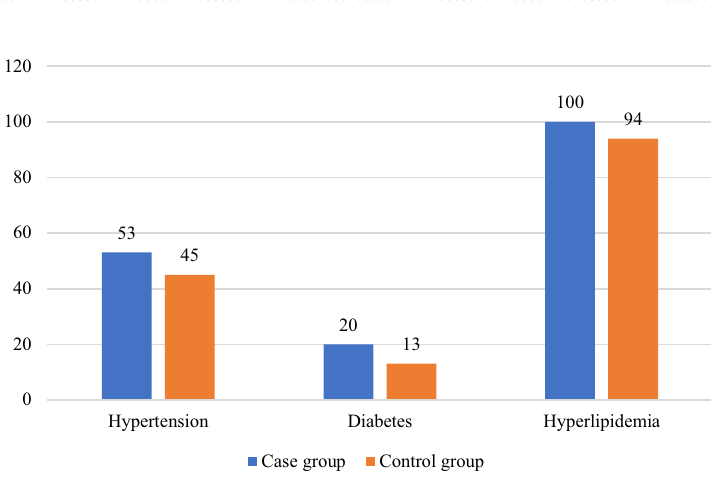
Figure 4. The numbers of subjects with comorbidities in the case and control